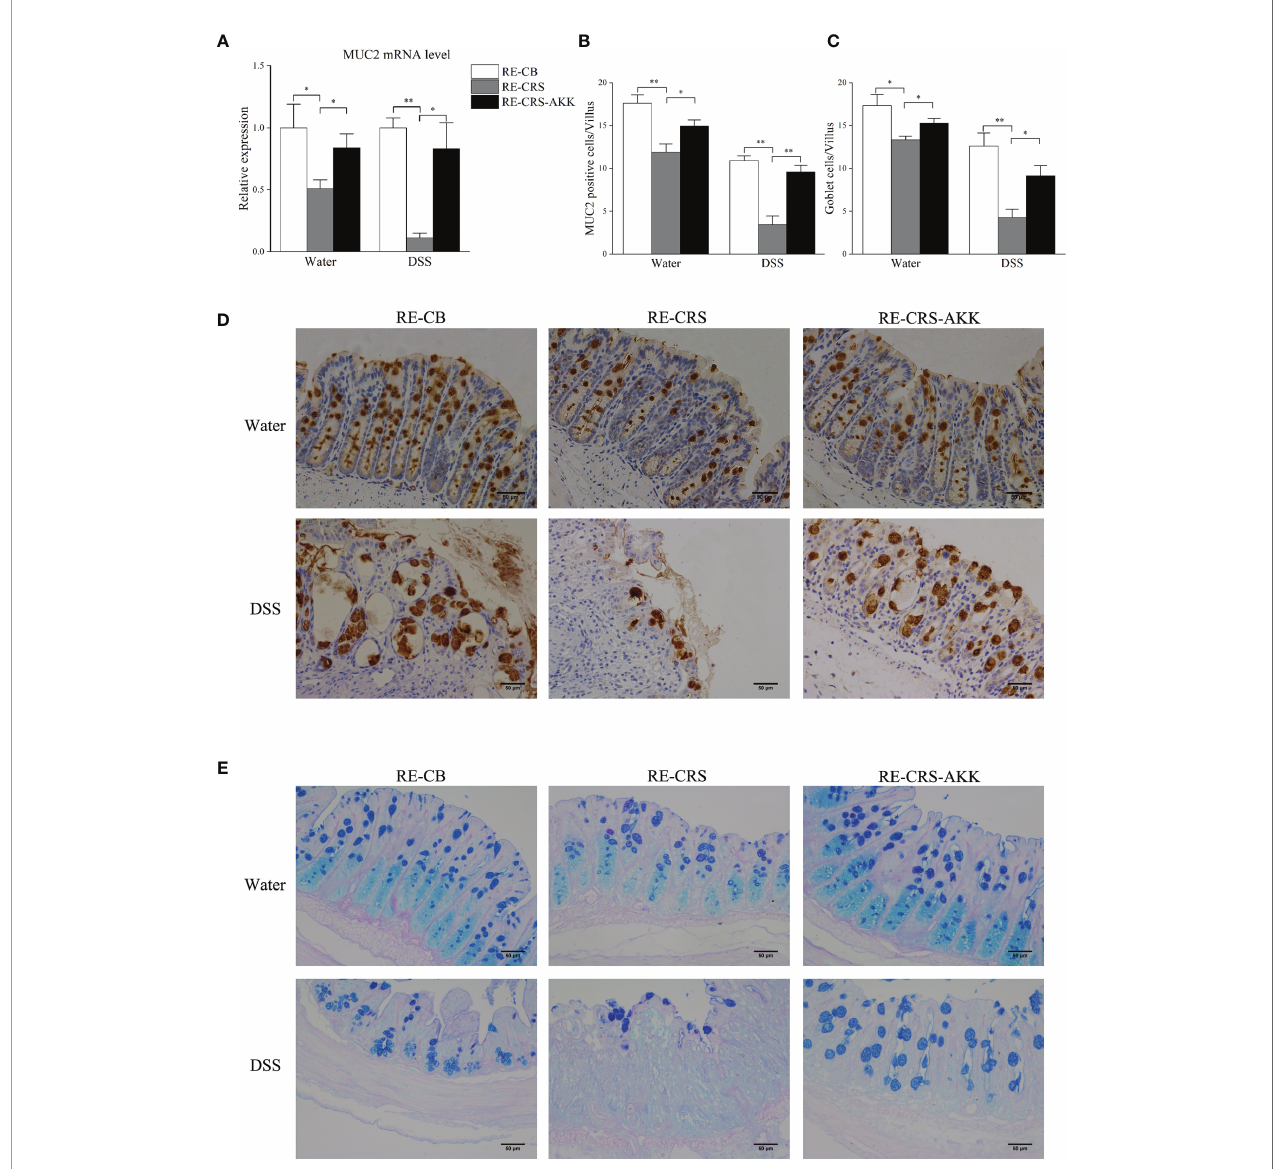
FIGURE 8 | A. muciniphila supplementation protected colonic mucosal defects in recipient mice. (A) A. muciniphila supplementation affected relative expression of MUC2 in mice. (B) Numbers of MUC2-positive cells in each villus (n = 4 – 5). (C) Numbers of goblet cells in each villus (n = 4 – 5). (D) Representative photographs of colonic MUC2 immunostaining (magni fi cation ×200, scale bar: 50 m m). (E) Representative photographs of colonic specimens stained with PAS/AB (magni fi cation ×200, scale bar: 50 m m). *p < 0.05, **p <